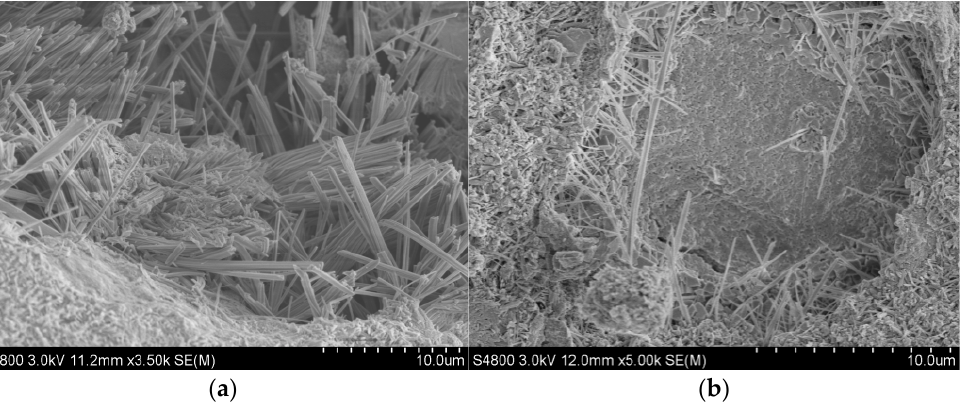
Figure 5. SEM images of MOC benchmark sample and 20% fly ‐ ash ‐ doped MOC sample after immersion in water: ( a ) MOC benchmark; and ( b ) MOC sample mixed with 20% fly ash.